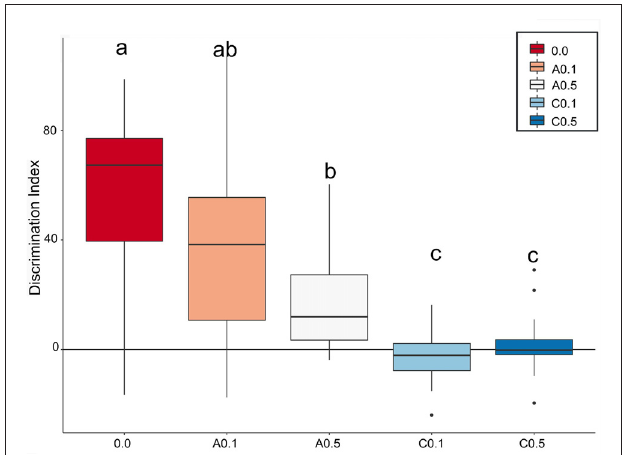
FIGURE 3 | Index box plots represent the relative median values of discrimination index (D i = B − A3) for the five groups tested in comparison with a theoretical mean of 0. Groups C0.1 and C0.5 together showed the lowest values of discrimination, while the A0.1 presented discrimination similar to control group. Different letters represent statistic difference between groups. Isolated dots correspond to outliers’ values. For further details and statistical analyses, see the “Statistical Analysis”